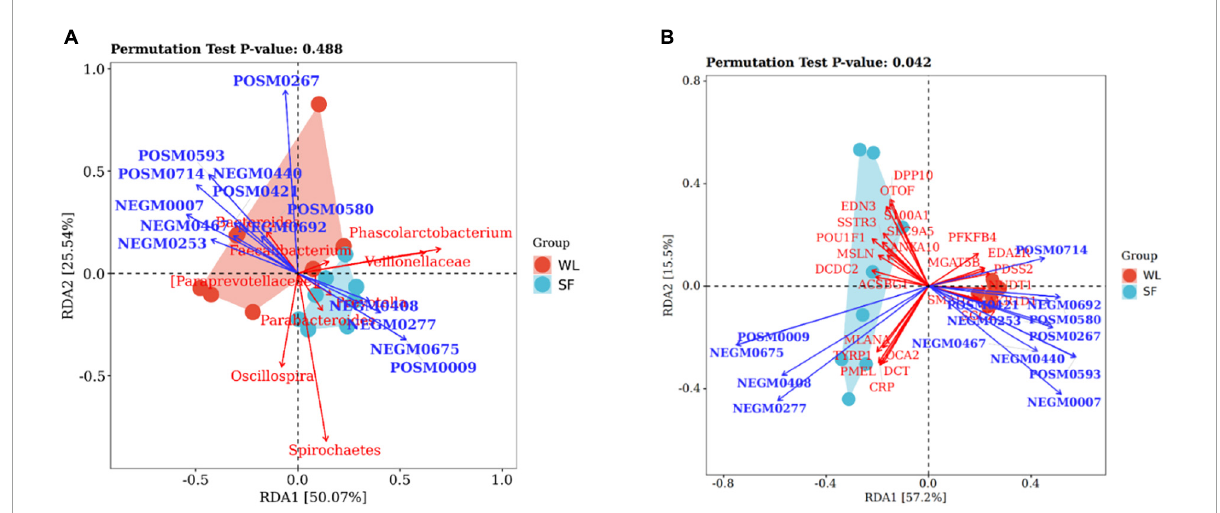
FIGURE5 Redundancy analyses between microbes, metabolites and DEGs. (A) RDA between significantly different microbe and metabolite. (B) Relationship between metabolite and DEGs by RDA. Brackets are used to emphasize that this is the official Greengenes database recommended taxonomic information, there may be corrections or improvements to this taxonomic